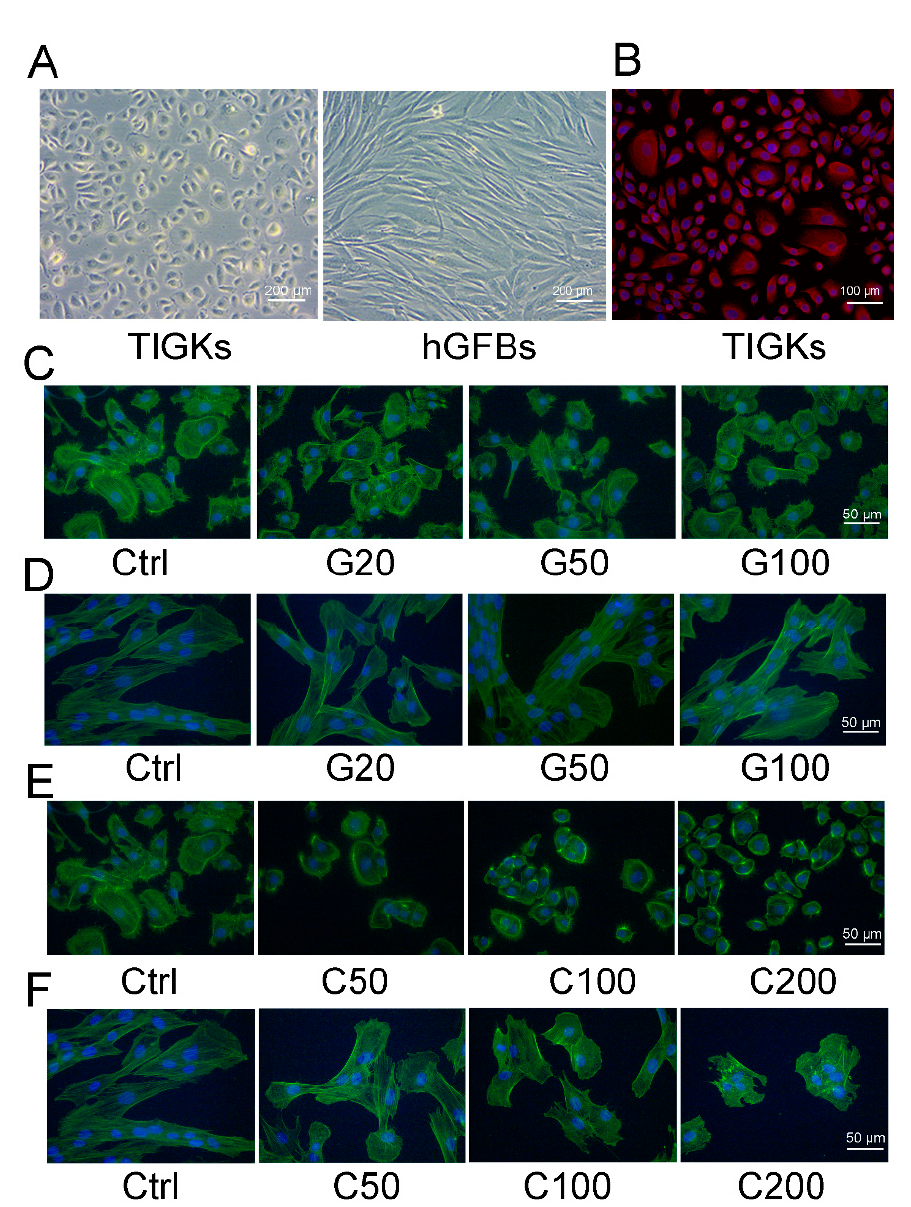
Figure 2. Photomicrographs showing the appearance of the TIGKs/hGFBs in the 2D monolayer culture. ( A ). Phase-contrast microscopic image of the TIGKs and the hGFBs. ( B ). Cytokeratin 14 (K14) staining of the TIGKs (in red). ( C ). Actin staining of the TIGKs (in green) after treatment with genipin. ( D ). Actin staining of the hGFBs (in green) after treatment with genipin. ( E ). Actin staining of the TIGKs (in green) after treatment with cytochalasin D. ( F ). Actin staining of the hGFBs (in green) after treatment with cytochalasin D. Nuclear DNA was labelled with DAPI (shown in blue) in ( B – F ). Abbreviations: hGFBs: hTERT-immortalized gingival fibroblasts; hTIGKs: hTERT-immortalized gingival keratinocytes. Ctrl: control; G20: 20 µM genipin; G50: 50 µM genipin; G100: 100 µM gen- ipin, C50: 50 nM cytochalasin D; C100: 100 nM cytochalasin D; C200: 200 nM cytochalasin D.